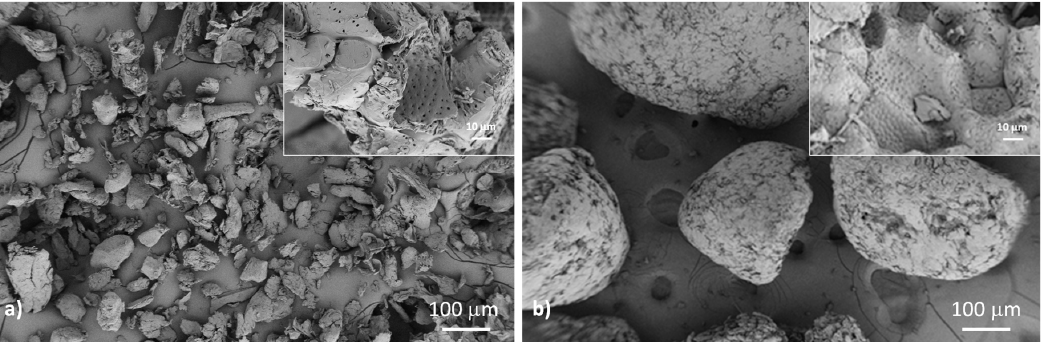
Figure 1. FESEM images of fine ( a ) and coarse ( b ) almond shell powders.